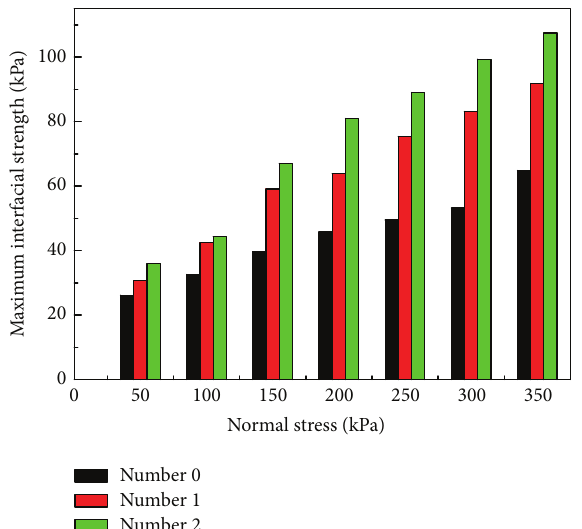
Figure 11: The vertical dilative displacement for interfaces of different